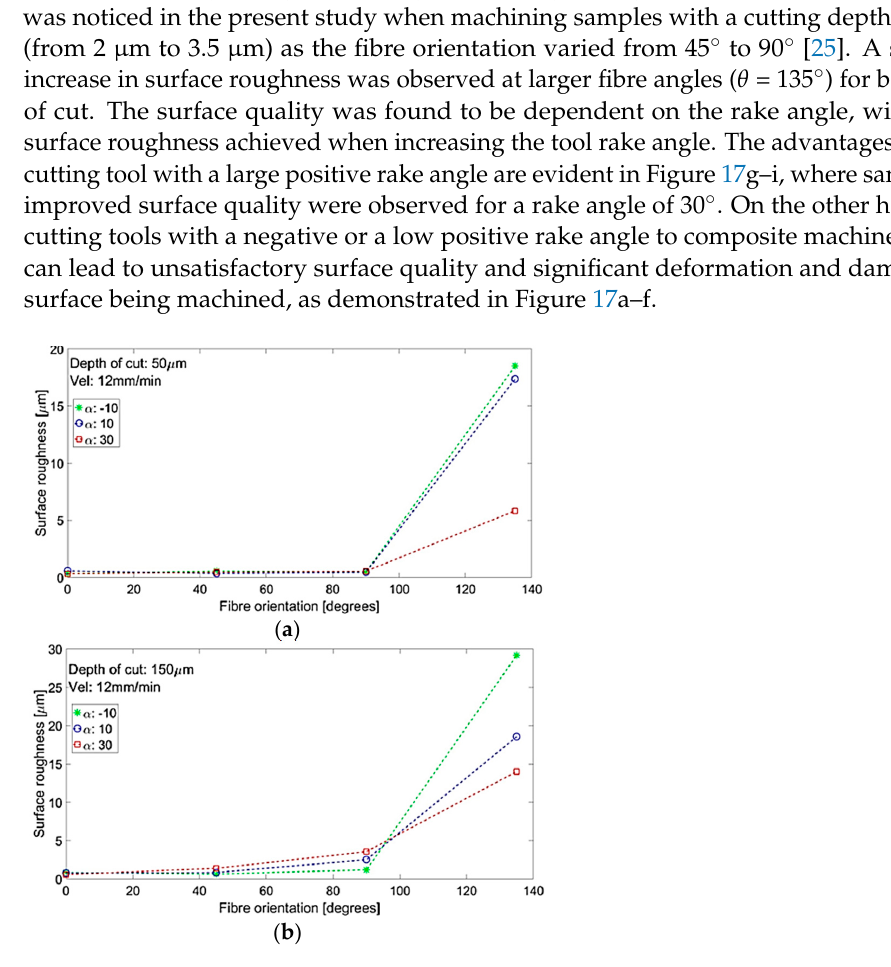
Figure 21. Surface roughness and fibre orientation at various tool rake angles at depths of cut of ( a ) 50 µm and ( b ) 150 µm.